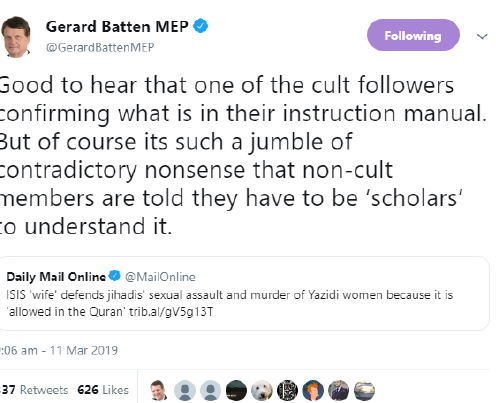
Figure 9. Tweet from UKIP leader Gerard Batten, 11 March 2019.